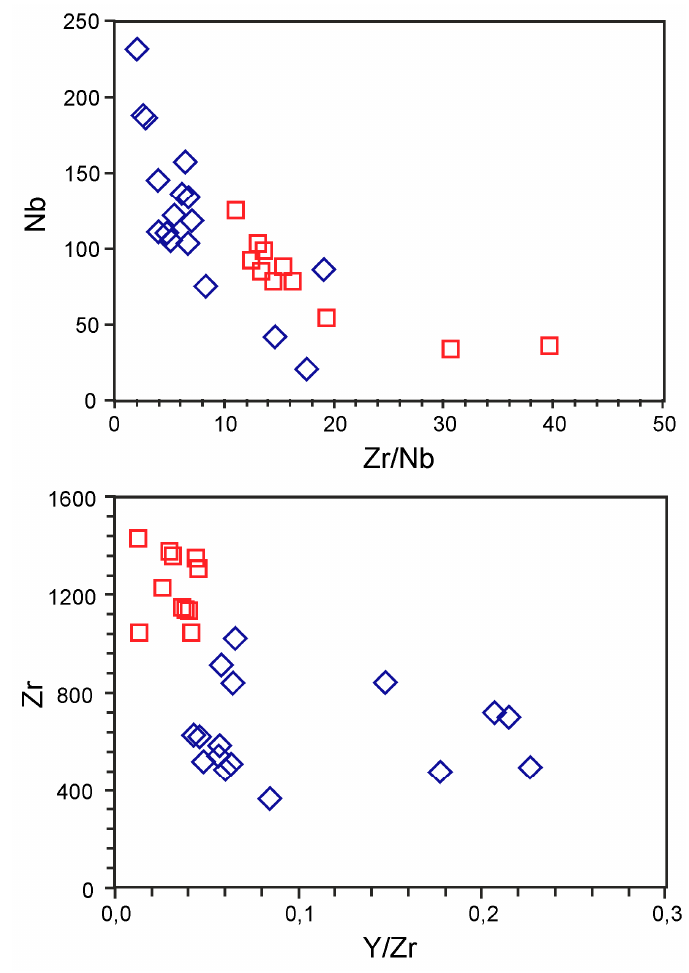
Figure 7. Selected paired trace-element ratios for the Breivikbotn silicocarbonatite and associated melteigite (blue diamonds and red squares, respectively).